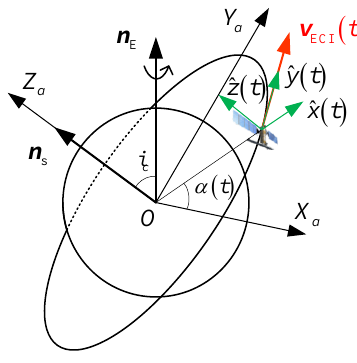
Figure 4. The auxiliary coordinate system.